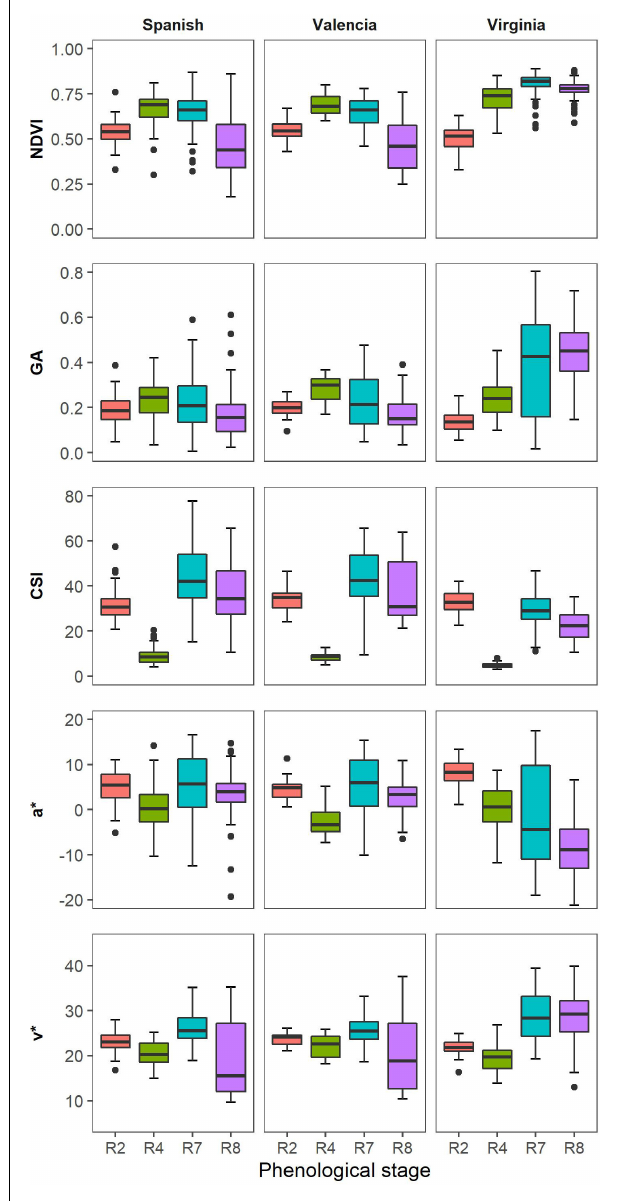
FIGURE 3 | Box plots illustrate the distribution of selected VIs of the different market types across four time points during the growth